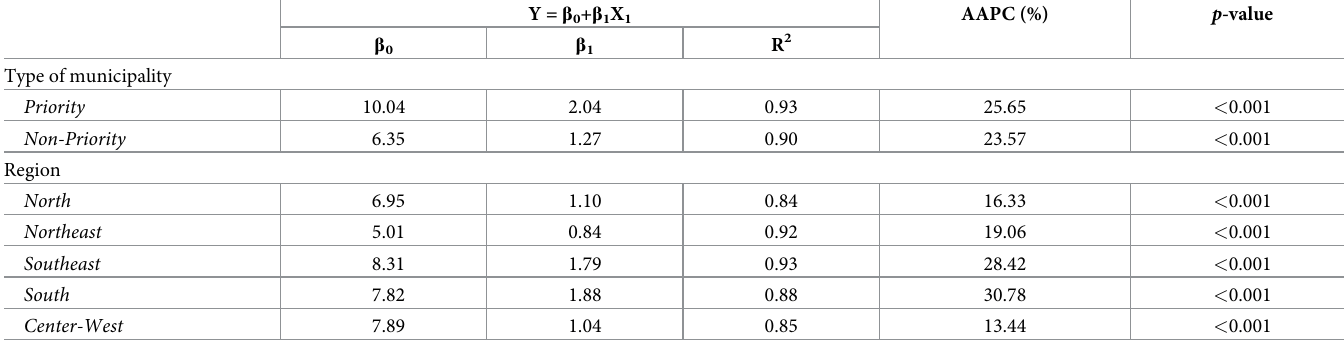
Table 2. Trend analysis of syphilis in pregnancy rate in priority and non-priority municipalities and according to regions of Brazil, from 2007 to 2017. Database: National System of Aggravations and Notification—SINAN (2018).